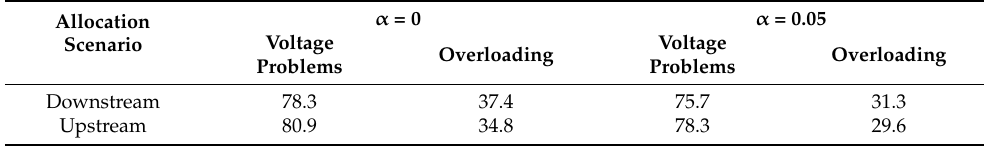
Table 4. Percentage of feeders with technical problems.